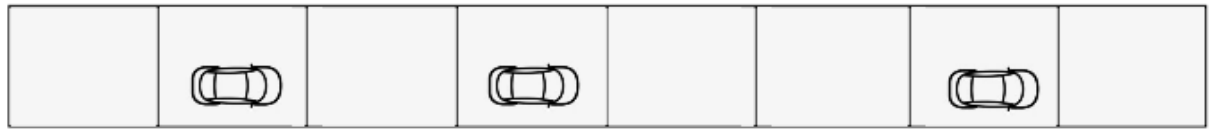
Figure 1. Cellular automata